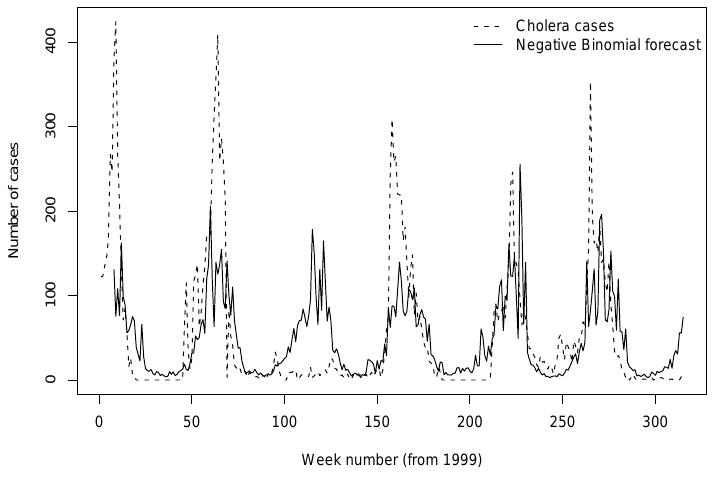
Figure 9: Model fit of negative binomial